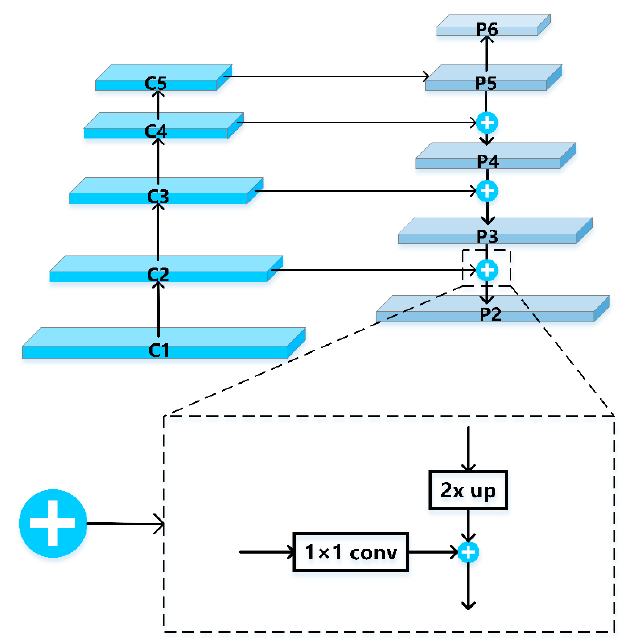
Figure 8. A top-down architecture with lateral connections.